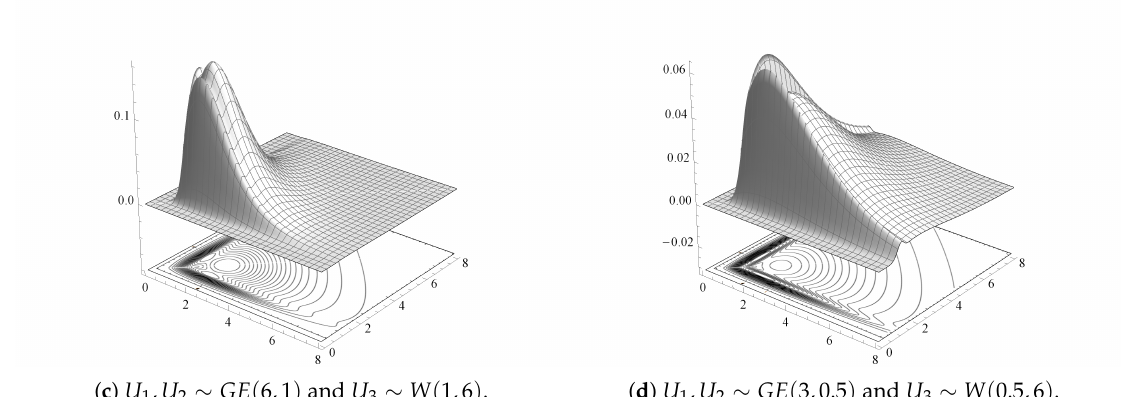
Figure 1. Surface and contour plots of the joint pdf of GBD models ( X 1 , X 2 ) with different components ( U ) 1 , U 2 , U 3